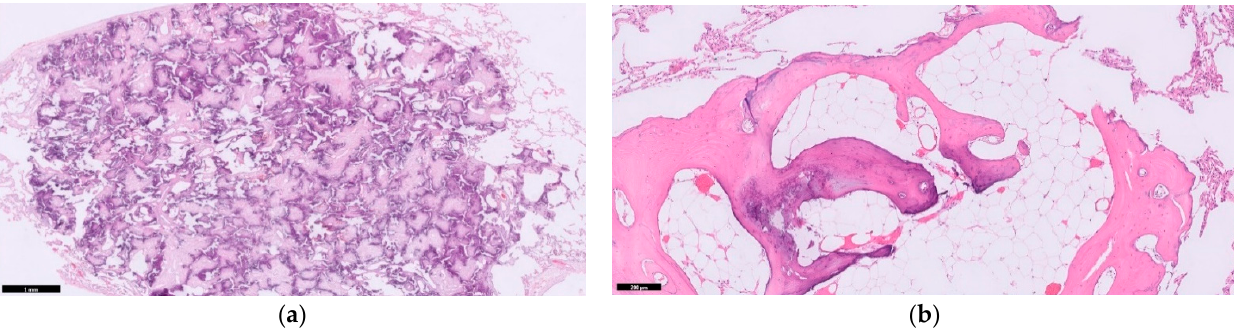
Figure 1. Different forms of pulmonary ossification. ( a ) A rounded nodular ossification; ( b ) Coral-like dendriform ossification, interwoven through the alveolar septa and containing fatty marrow deposits with haematopoetic stem cell tissue (arrow). HE stain, magnification ( a ) 40×; ( b ) 100×.